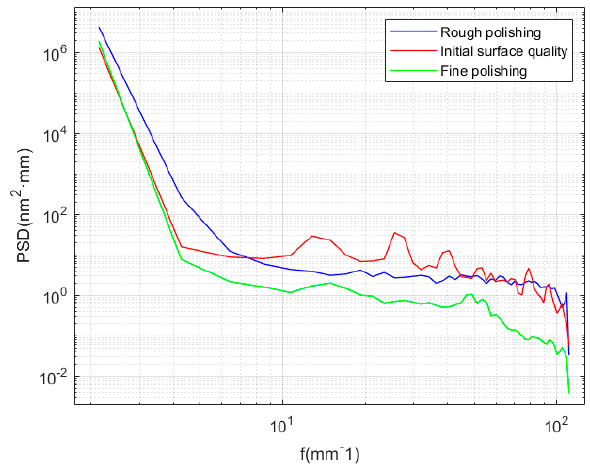
Figure 26. PSD curve under different polishing parameters.